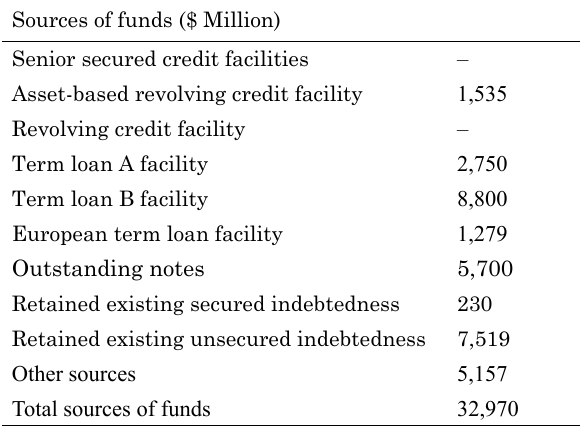
Table 1. The sources of the funds from